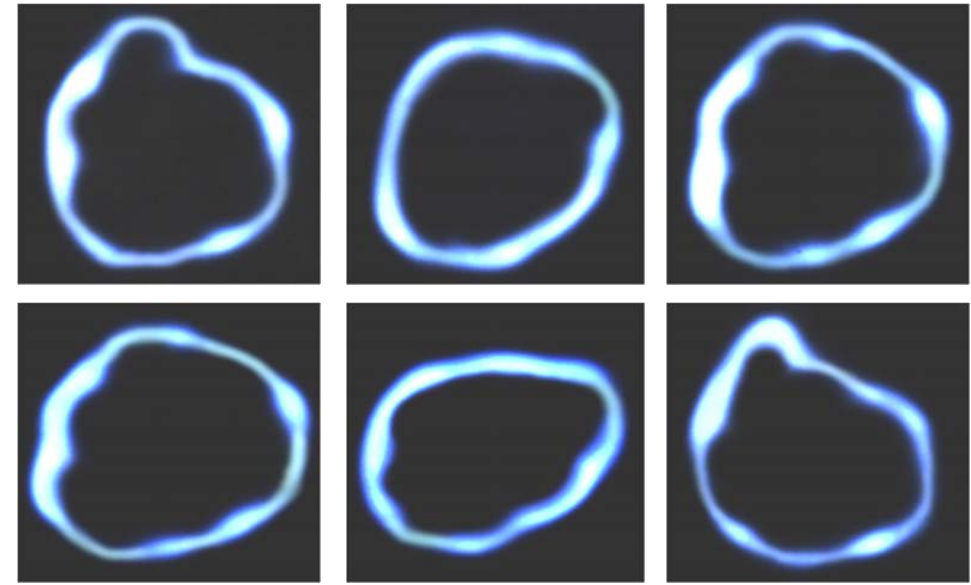
Figure 4: CT-Scan images of different capsules by shell thickness from 0.7 to 1.2 mm.